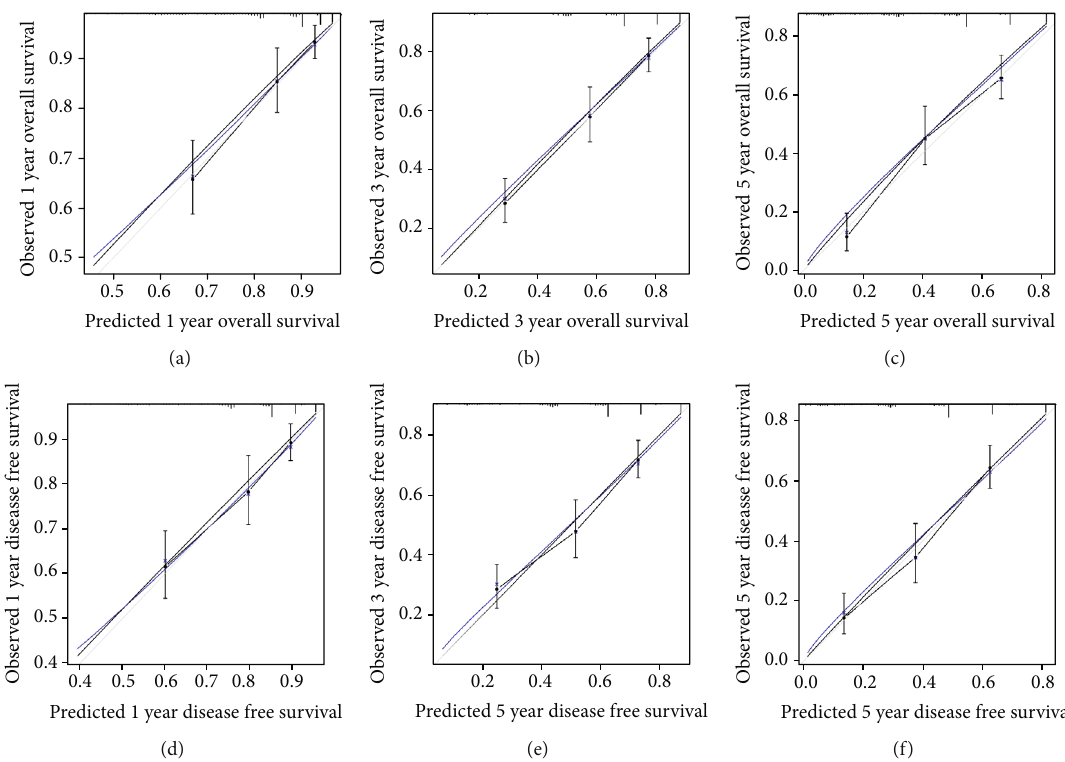
Figure 2: Calibration curve for predicting patient survival at (a, d) 1 year, (b, e) 3 years and (c, f) 5 years in the validation cohort. Nomogram-predicted overall survival/disease free survival (DFS) is plotted on the x -axis; observed overall survival/disease free survival is plotted on the y -axis.